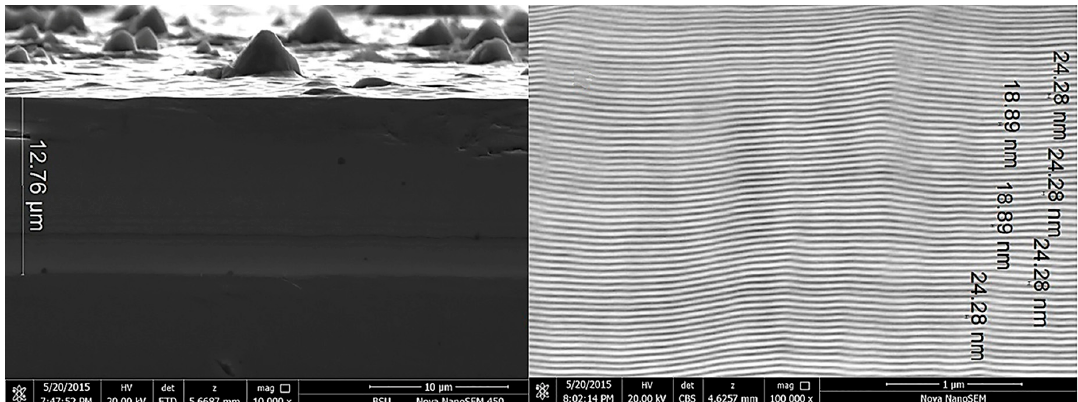
Figure 7. Cross sectional TEM images of TiN/ZrN multilayer coatings with modulation periods of about 40 nm deposited at U b = − 150 V [123].